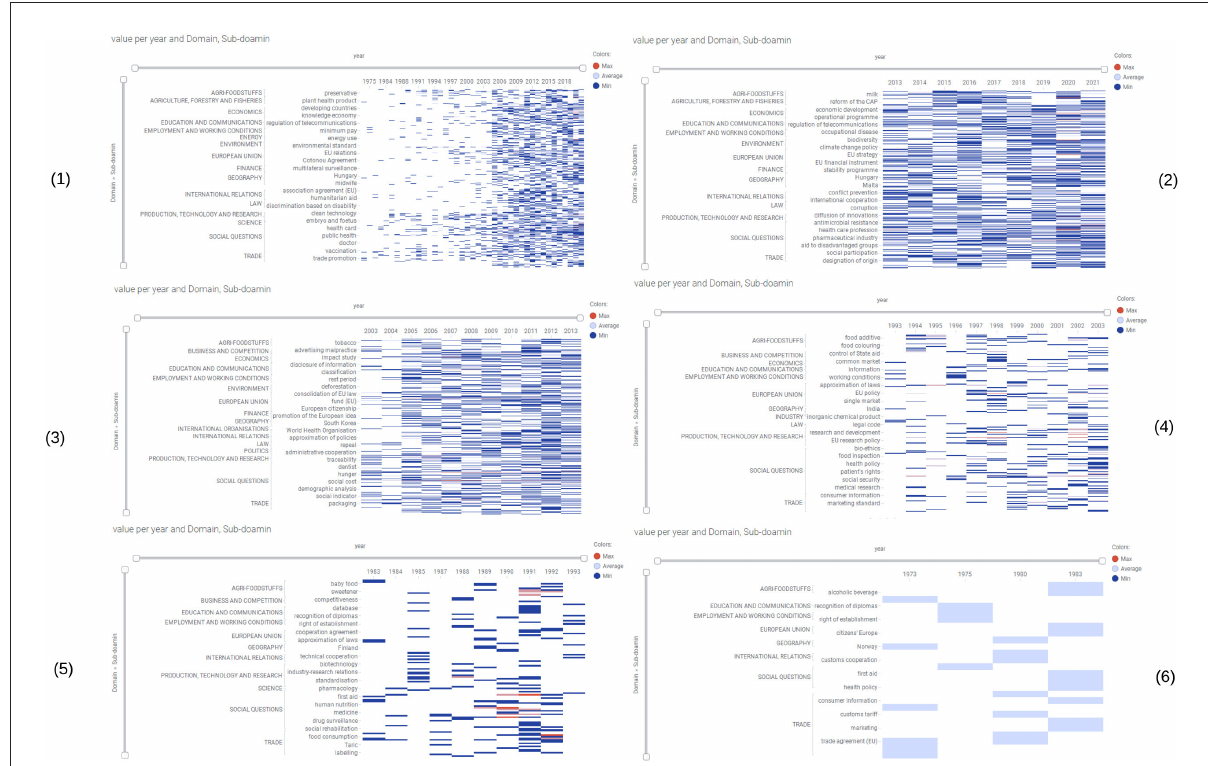
FIGURE3 Snapshots of the interactive heatmap of the most commonly used EuroVoc terms over the years. Legend, The heatmap contains domains and subdomains in the columns and years in the rows. The interactive heatmap allows users filtering by years, domains and subdomains. Snapshot (1) represents the heatmap covering EuroVoc terms from 1973 to 2021, (2) from 2013 to 2021, (3) from 2003 to 2013, (4) from 1993 to 2003, (5) from 1983 to 1993 and (6) from 1973 to 1983. The colors indicate the number of EuroVoc terms. The interactive heatmap is available at the following link: